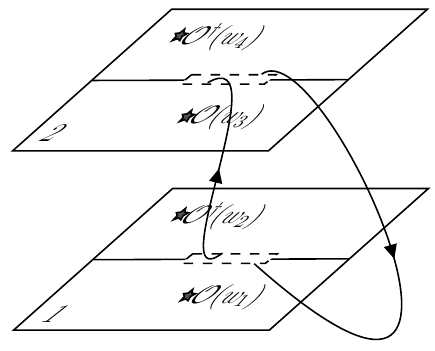
Figure 1. The 2-sheeted space Σ 2 . The dashed box represents the subsystem A